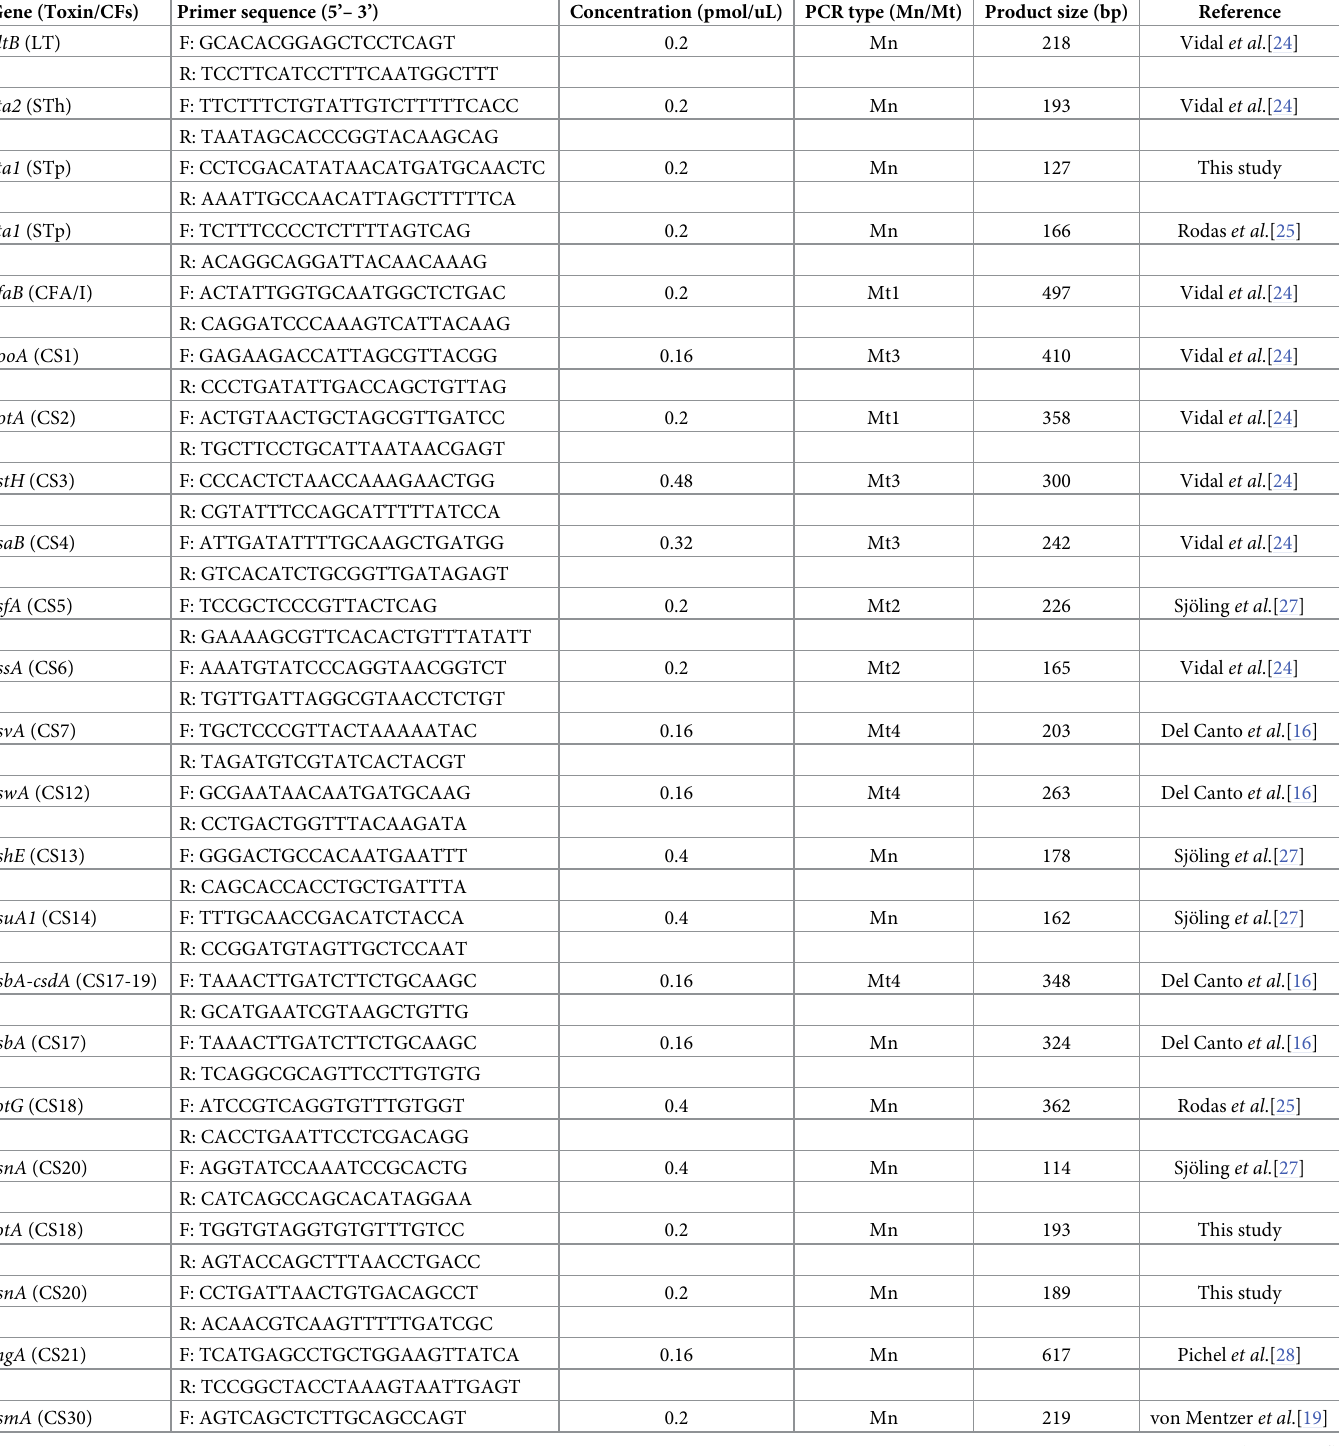
Table 1. Primers used in this study for detection of toxin and colonization factor genes in ETEC strains. Gene